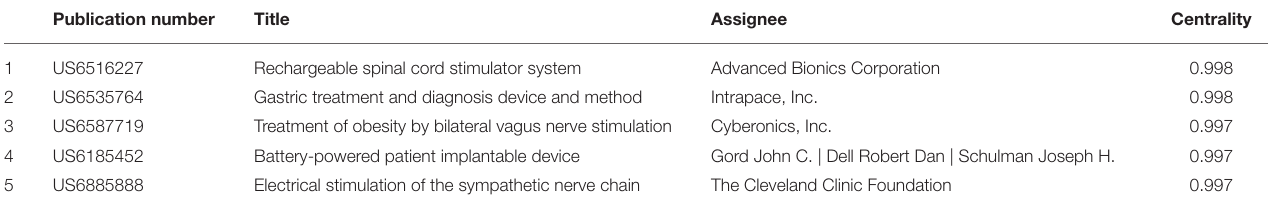
TABLE 8 | Top five central patents for the electrical energy-based therapeutic technological domain with their assignees and centrality values.